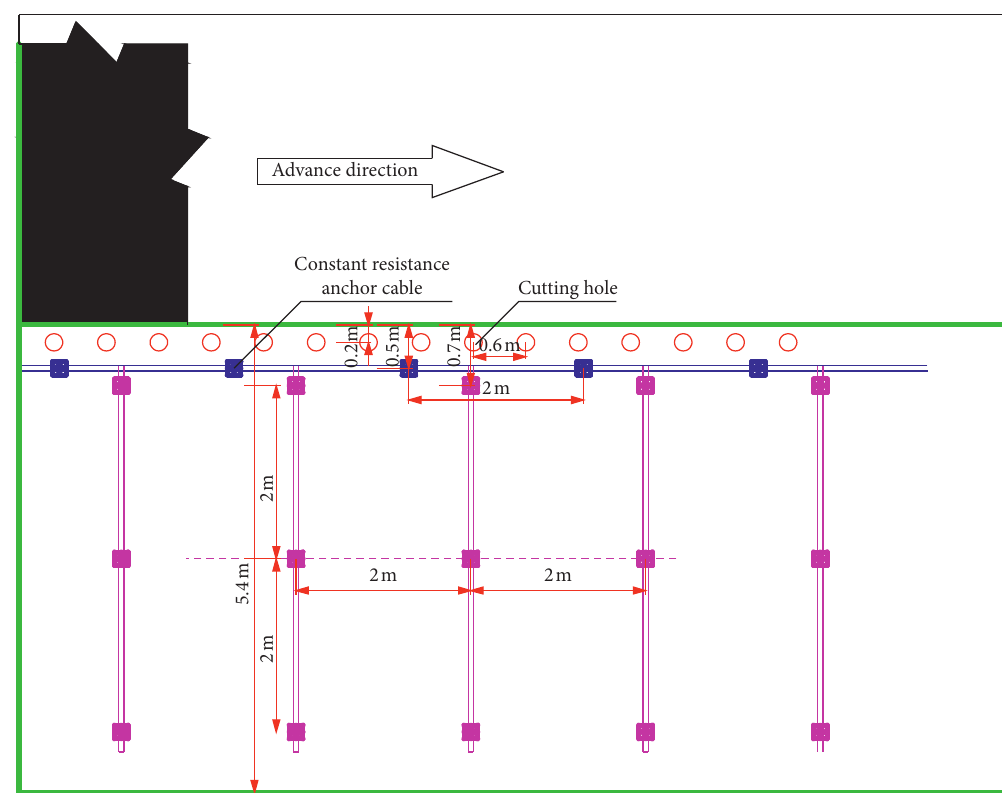
Figure 15: Slot hole layout